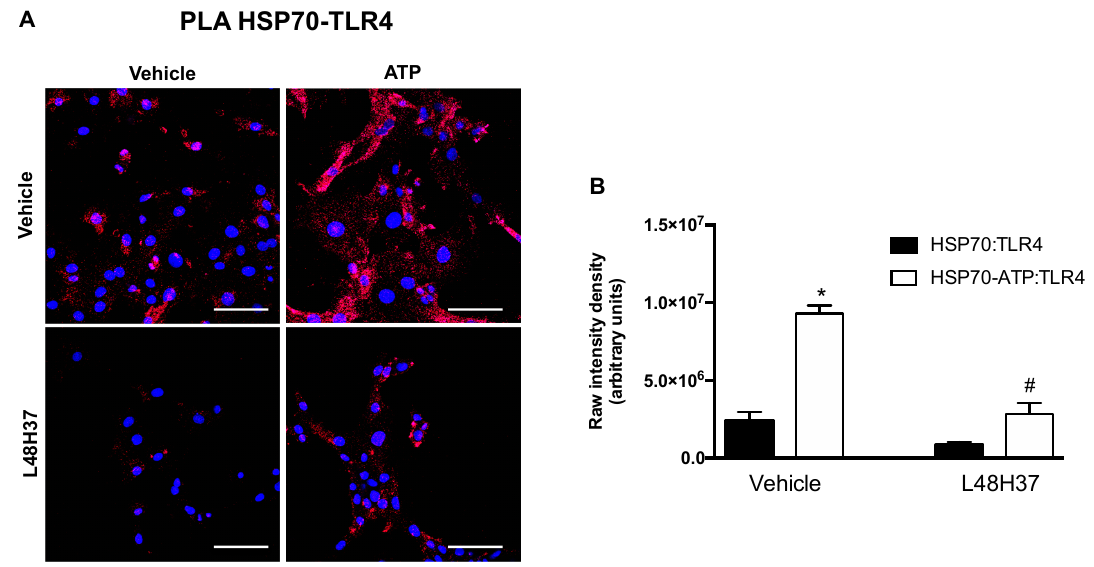
Figure 5. Proximity ligation assay produced red fluorescence spots, which suggests both target proteins (HSP70-TLR4) within interacting range. ( A ) Representative images (Scale bar: 20 µ m). ( B ) The raw fluorescence intensity (red) was analyzed using the ImageJ software. n = 6 images per group. ∗ p < 0.05 vs. HSP70:TLR4 vehicle treated and # p < 0.05 vs.